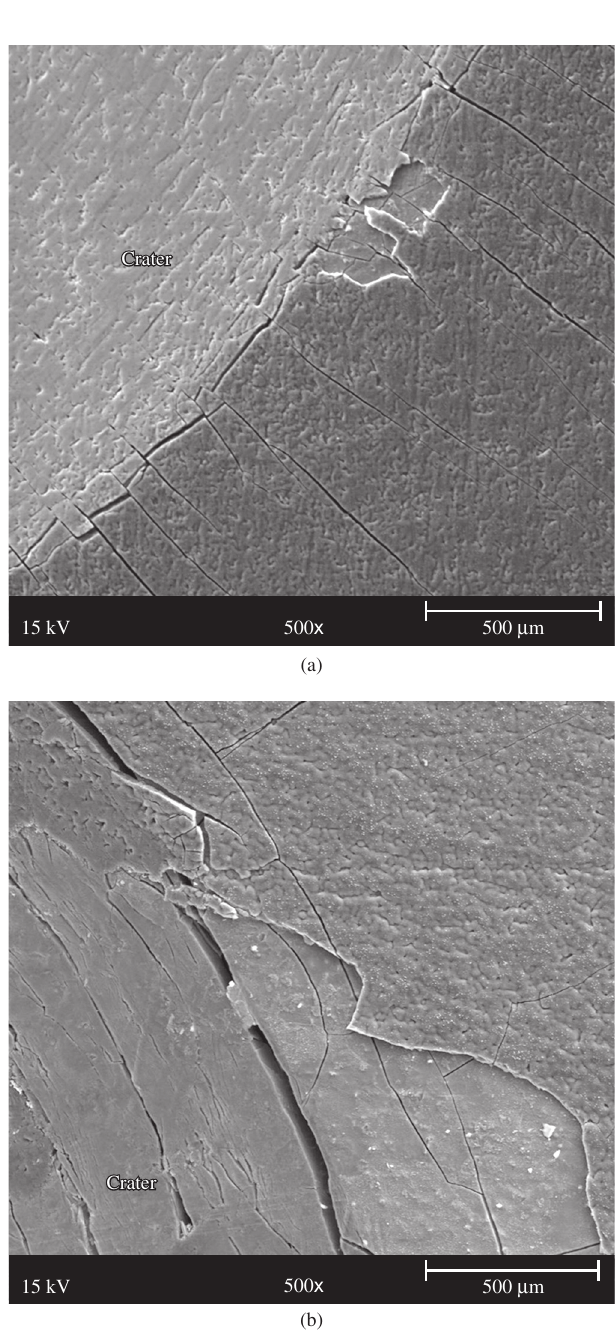
Figure 6. Damages adjacent to the craters produced by Rockwell-C inden- tations. Oxide films formed at a) 600 °C; and b) 650 °C after 48 hours of oxidation in